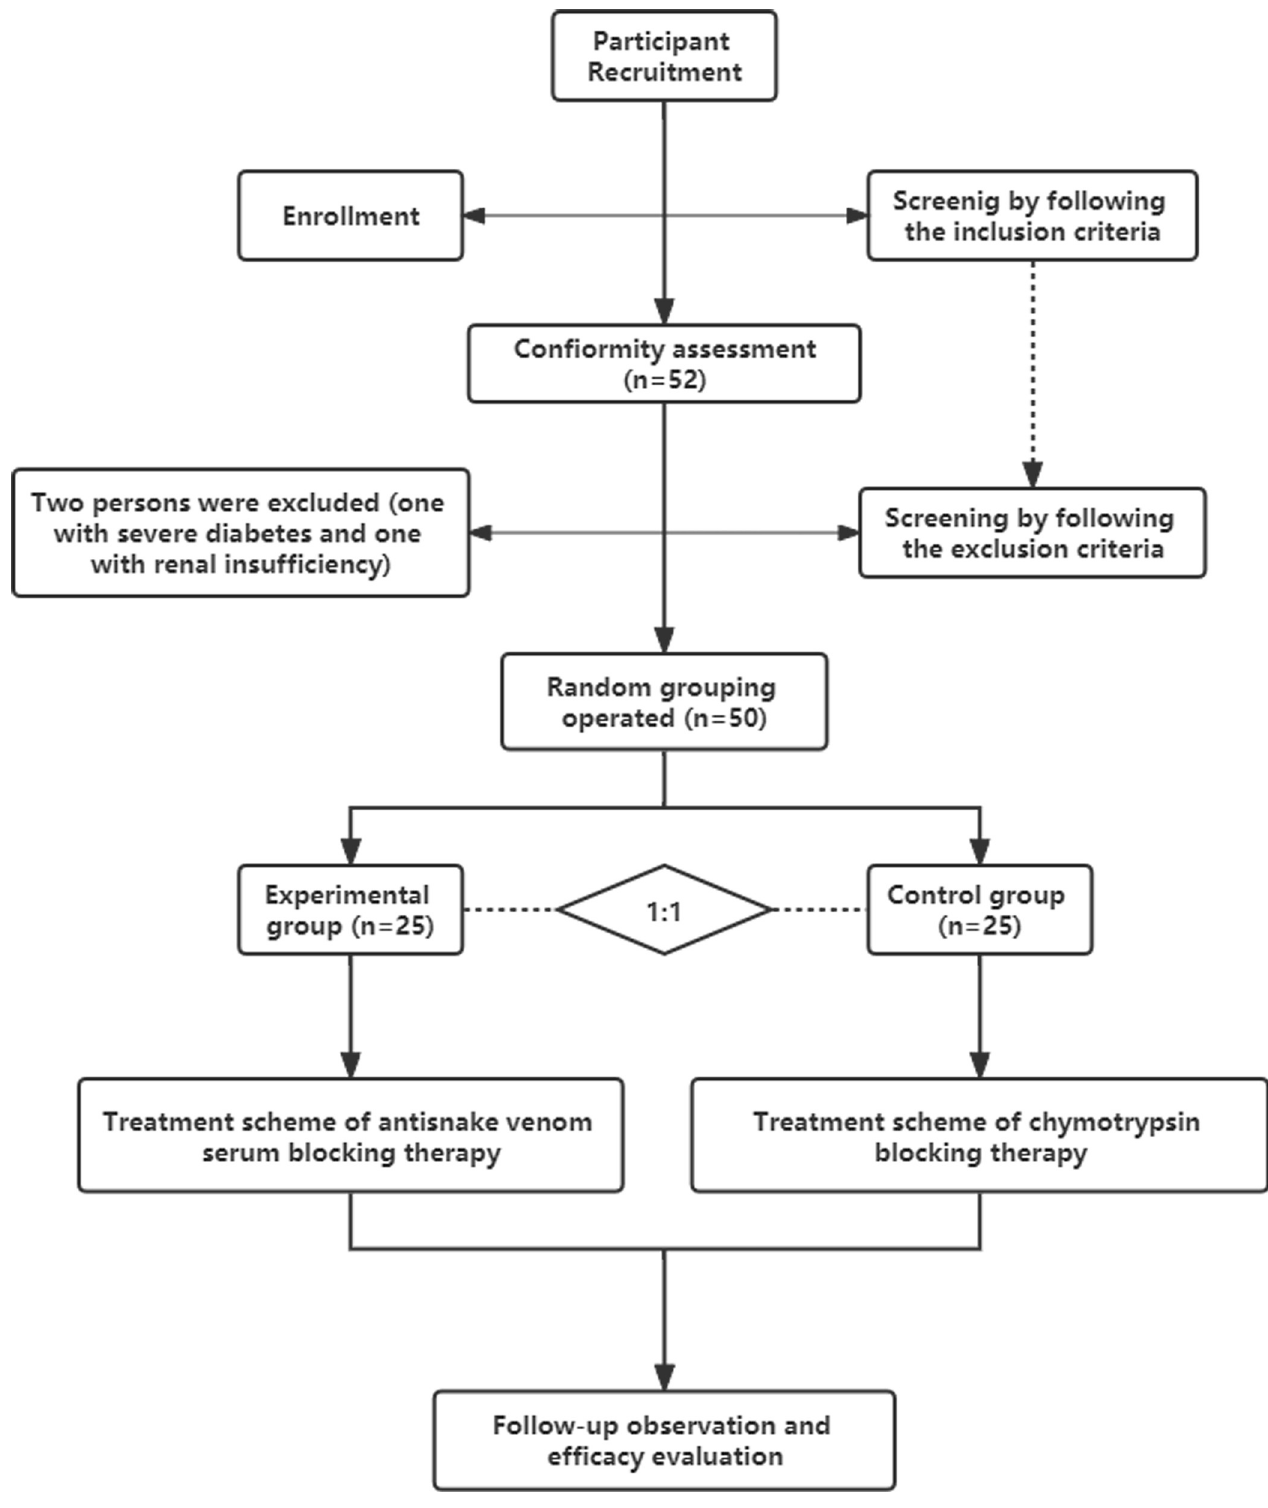
Fig 1. Flow diagram of patient enrollment treatment and follow-up.